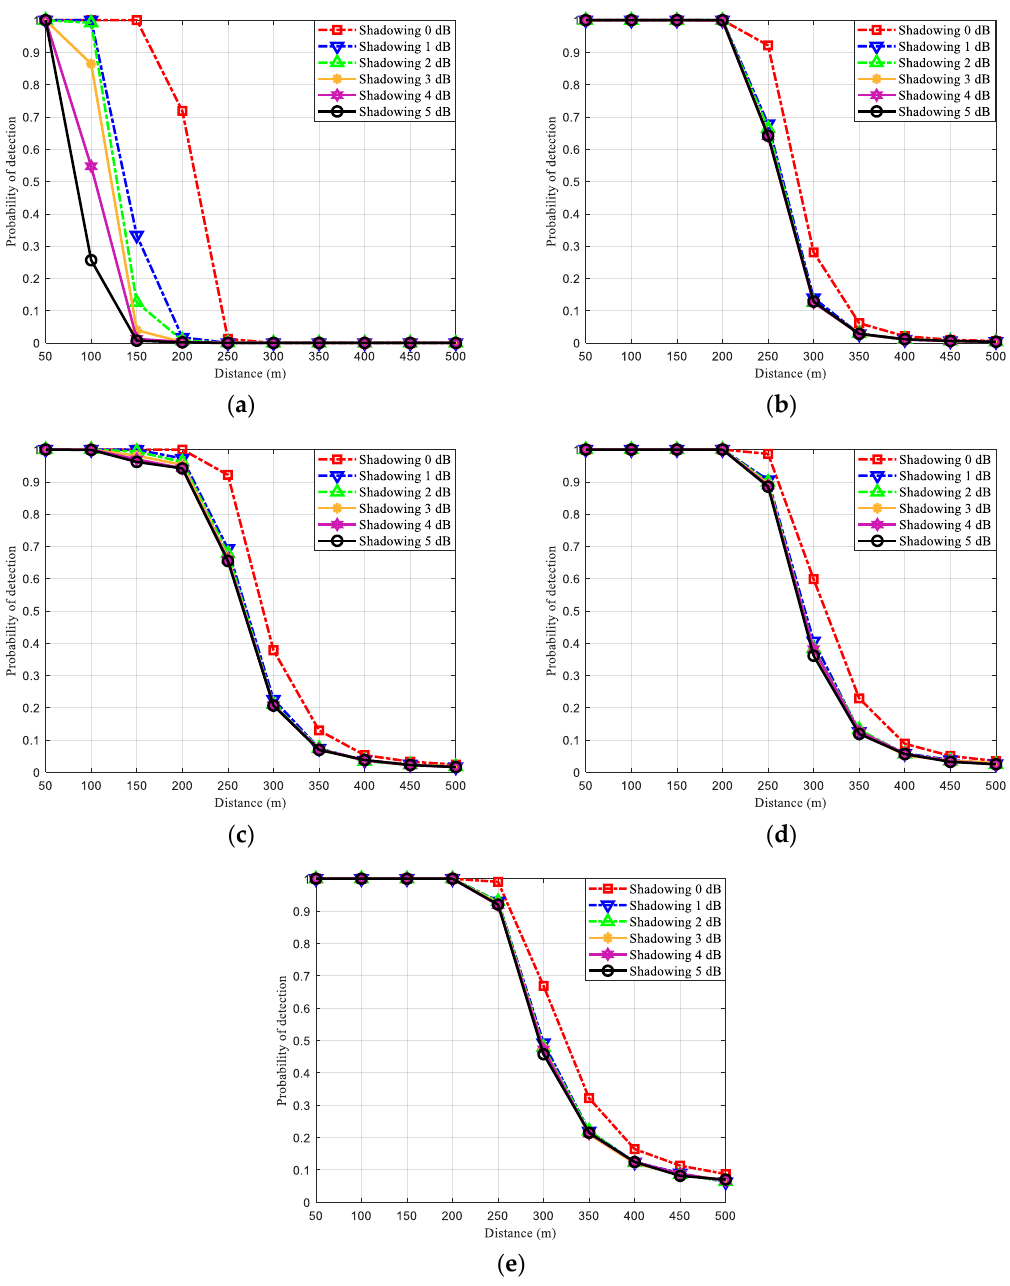
Figure 5. Investigation of Q d as a function of distance of each cooperative spectrum sensing technique. ( a ) AND rule; ( b ) the majority rule; ( c ) Adaptive majority rule; ( d ) IMA algorithm; ( e ) AMT algorithm. Table 1. The percentage of shadowing robustness (PB) for the shadowing at 1 to 5 dB as a function of distance at 250